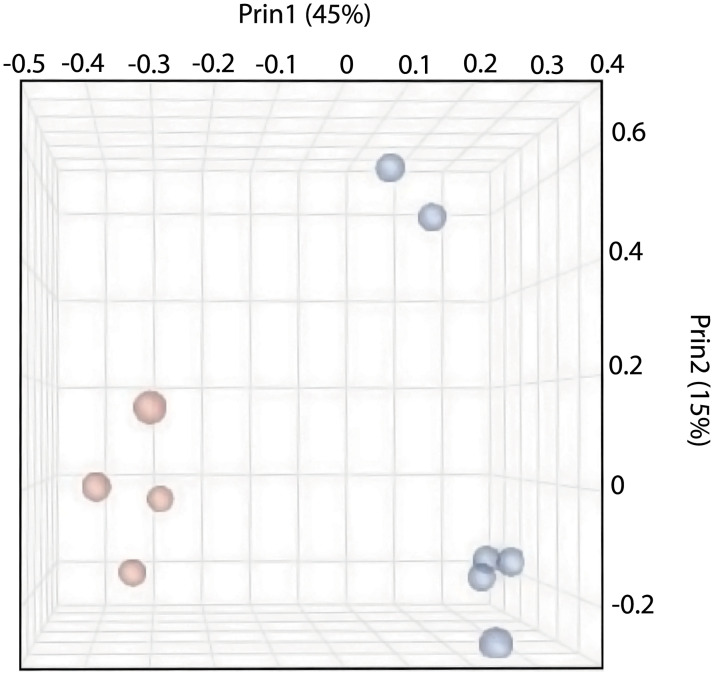
Principal component analysis (PCA) depicts some variation amongst Non-loaded controls (blue) possibly related to animal age or body mass, yet reveals a noteworthy and distinct segregation of Non-loaded controls from Hyperloaded (red) samples.Close grouping of Hyperloaded samples infers negligible effects of loading duration and frequency.